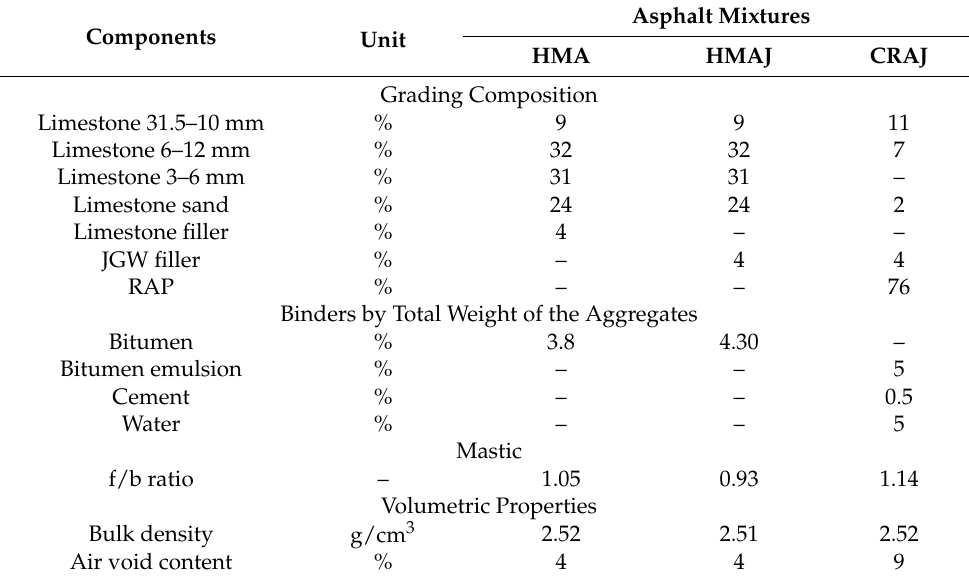
Table 5. Mixture composition and their volumetric